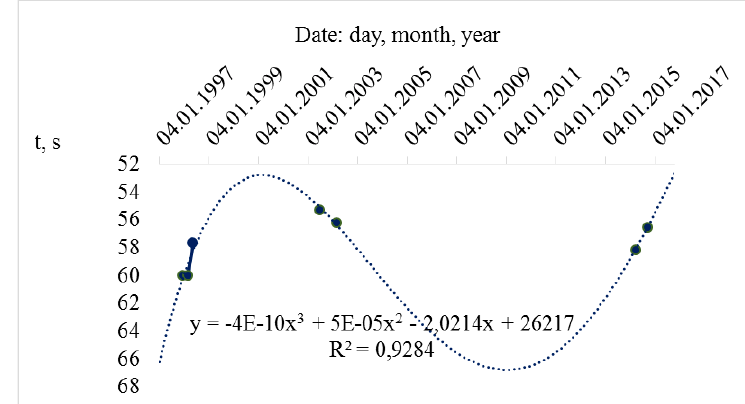
Fig. 2. Individual competitive performance of the athlete at a distance of 400 m: - results in international competitions; - a graph of polynomial regression, describing the dynamics of competitive performance from 1997